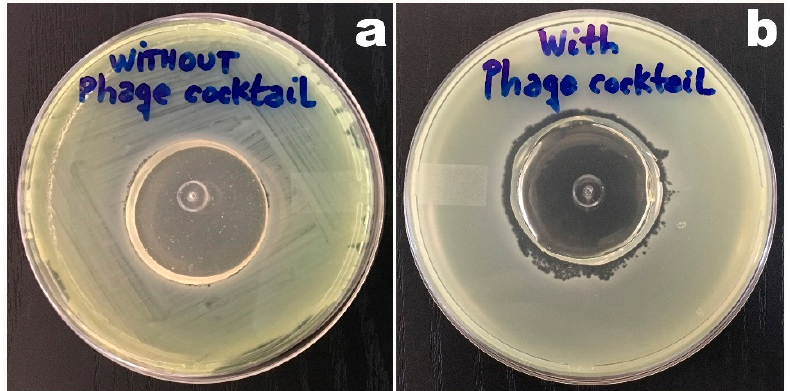
Figure 4. Results from evaluation of the lytic activity of the immobilized phages following integra- tion within the bio-reactive polymeric matrix with concomitant structural and functional stabiliza- tion. ( a ) Bio-reactive polymeric matrix devoid of phage particles. ( b ) Bio-reactive polymeric matrix integrating the cocktail of phage particles.